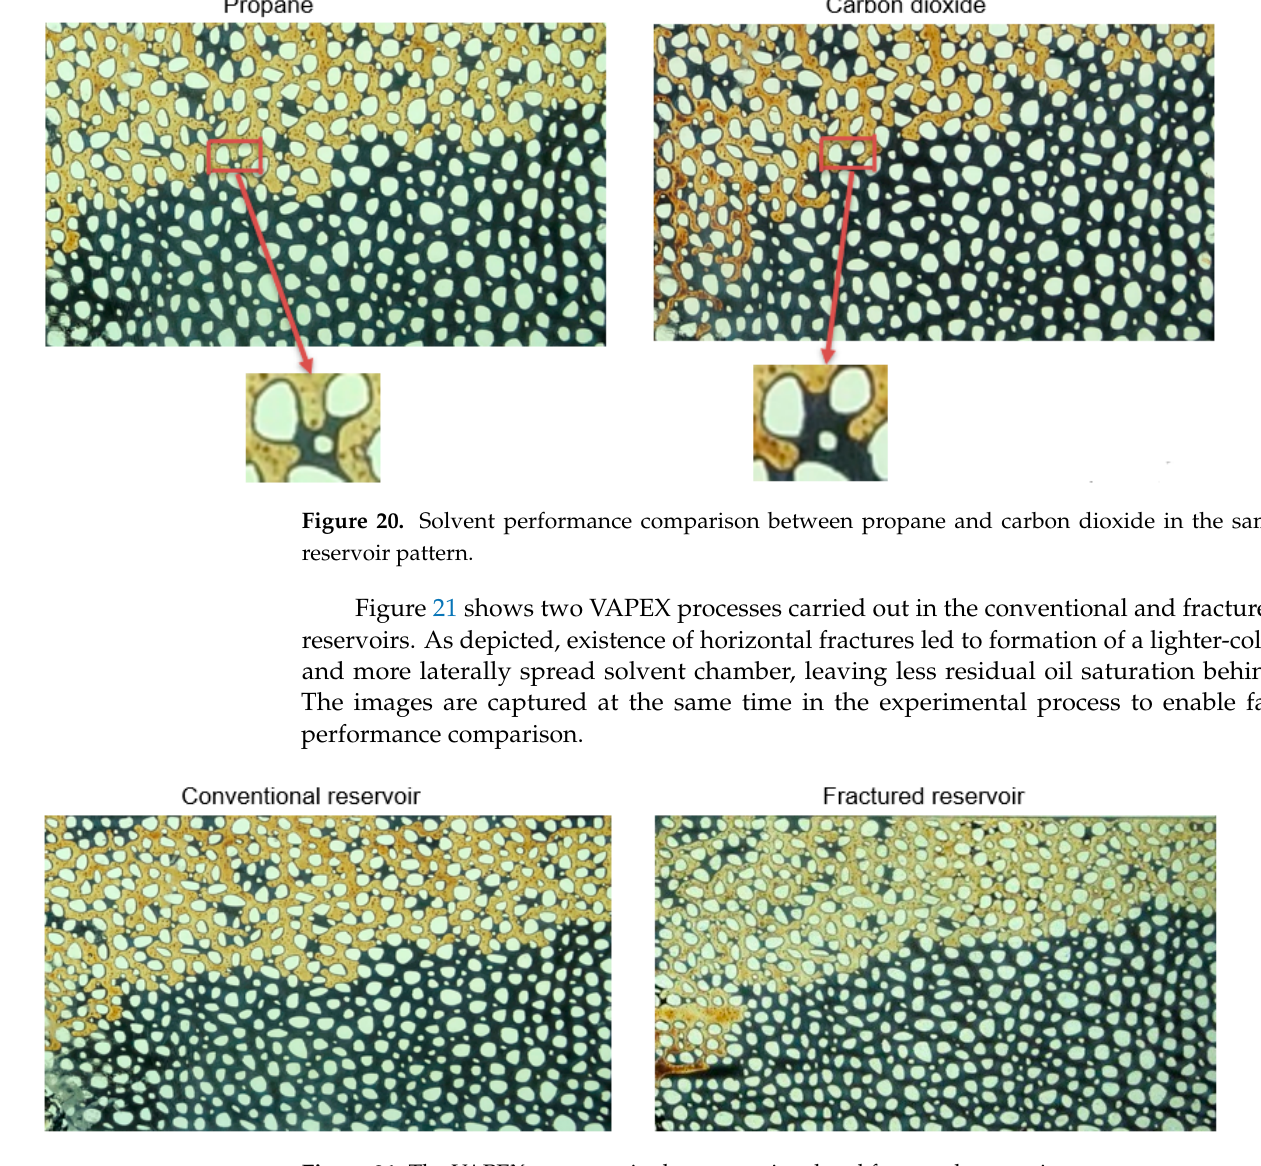
Figure 21. The VAPEX processes in the conventional and fractured reservoirs.